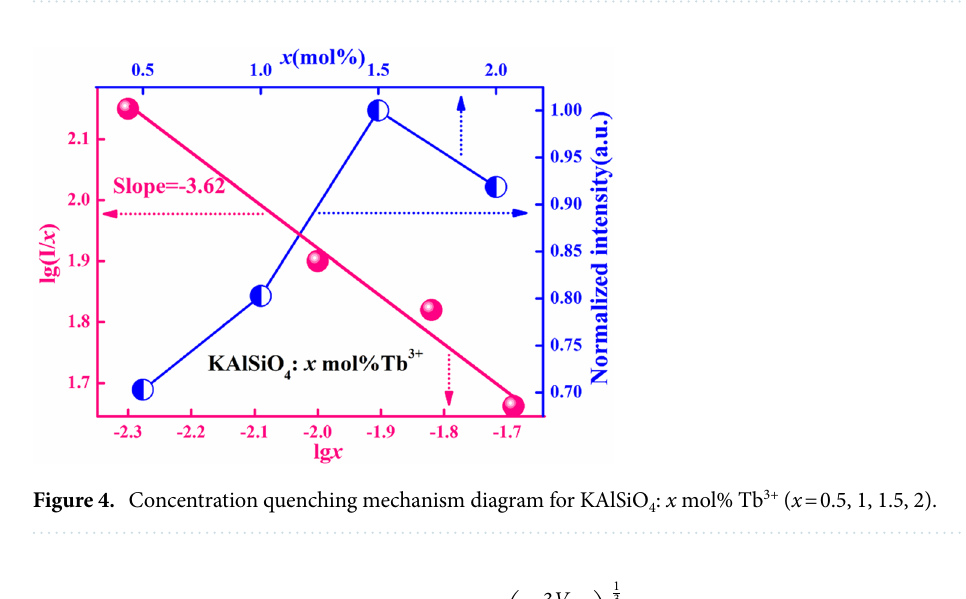
Figure 3. Excitation and emission spectra of KAlSiO 4 :1.5 mol% Tb 3+ (the inset is an enlarged view of the excitation spectrum from 325–425 nm).